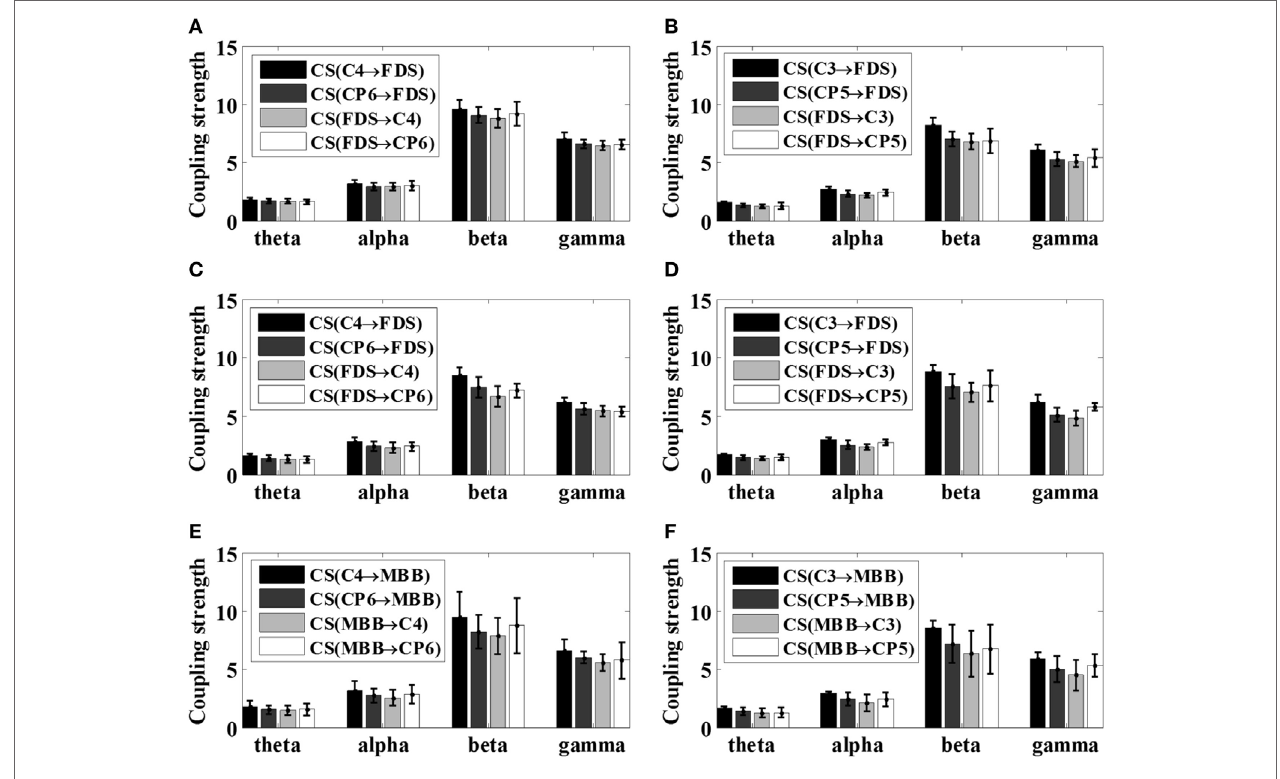
FigUre 7 | Mean coupling strength (CS) of healthy subjects (S6–S12) with respect to various motor tasks. (a) Left 5 kg; (B) right 5 kg; (c) left 10 kg; (D) right 10 kg; (e) left elbow flexion; (F) right elbow